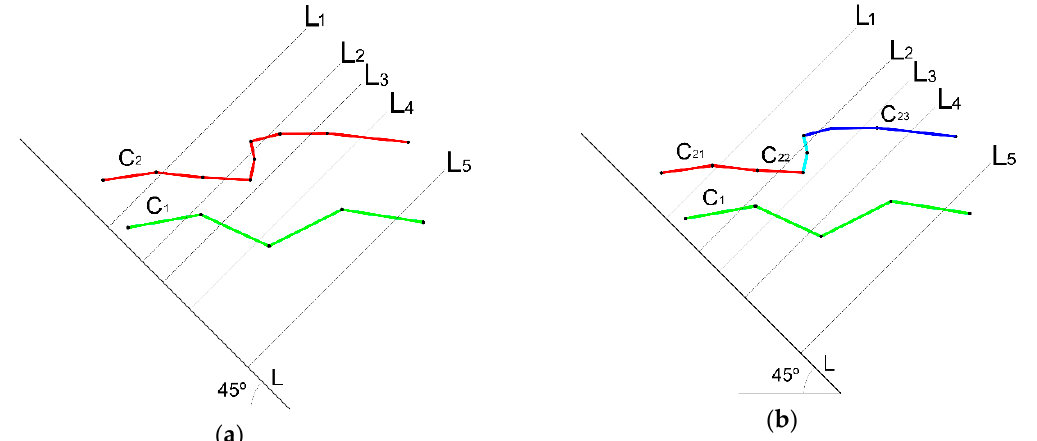
Figure 10. Chain monotone decomposition: ( a ) C 1 is monotone relative to L while C 2 is not, and ( b ) monotone decomposition of C 2 .